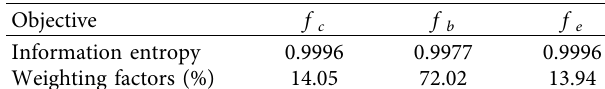
Table 8: Information entropy and weighting factors of different